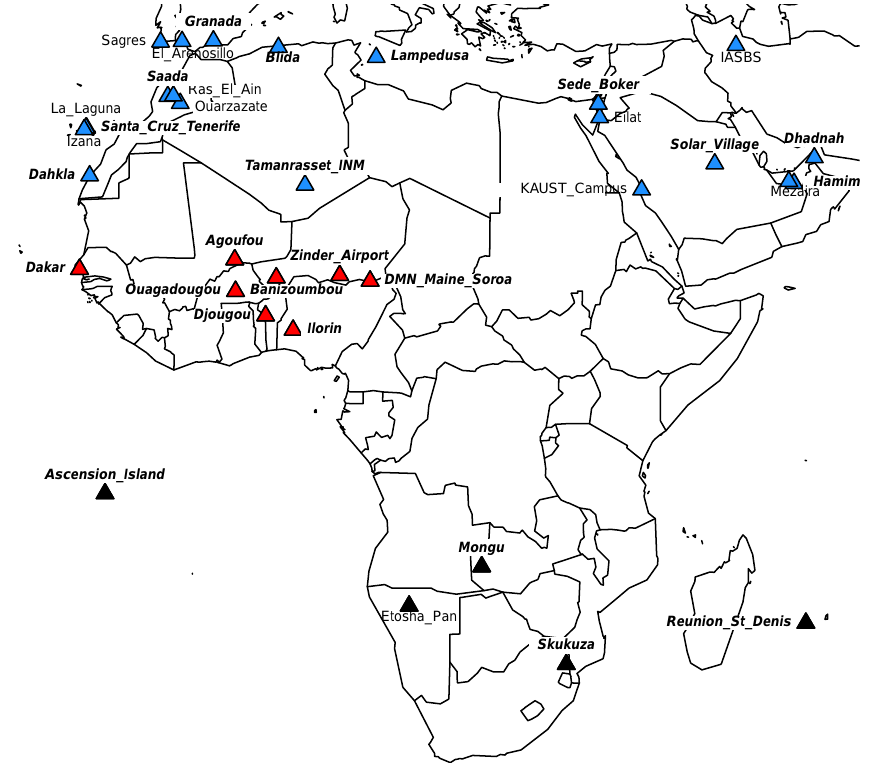
Figure 1. Map of long-term AERONET sites used in this study. Sites are color-coded by general geographic area and aerosol source type. Site names in bold italics are used in the model comparison.